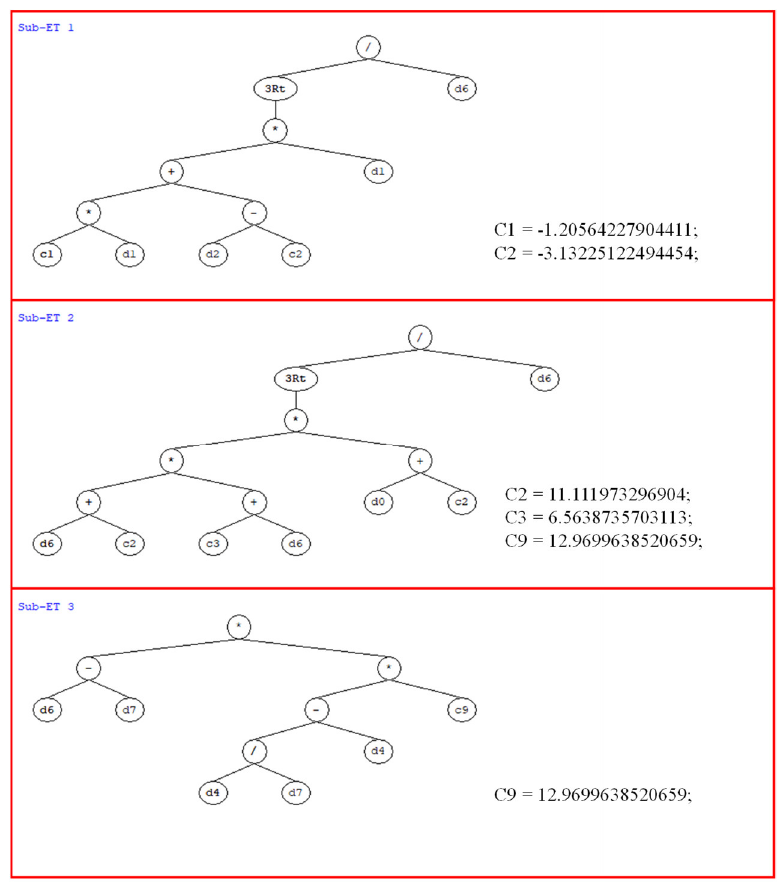
Figure 9. Expression tree generated from GEP model for optimized trial.